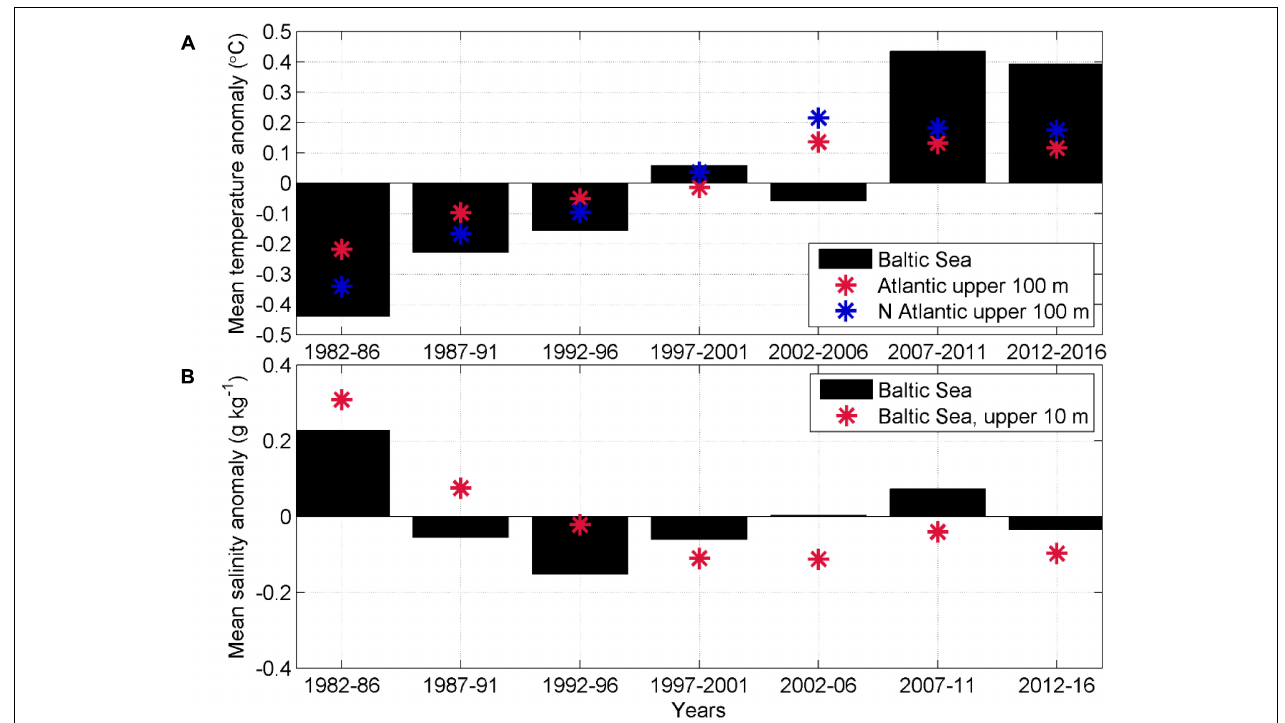
FIGURE 6 | Pentadal averages of temperature (A) and salinity (B) anomalies in the entire Baltic Sea in 1982–2016. Pentadal averages of temperature in the upper 100 m in the Atlantic Ocean and its part in the northern hemisphere are shown in the upper panel. Extended time-series of vertically integrated temperature change in the (Northern) Atlantic Ocean by Levitus et al. (2012) are